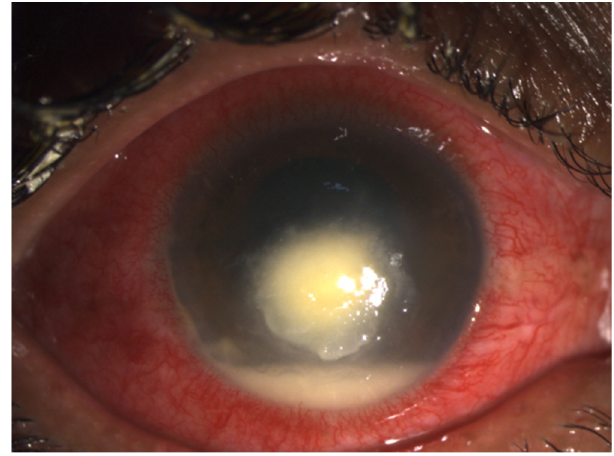
Figure 1. Clinical photograph of a 30 year old female patient with history of trauma to right eye showing central dry-looking corneal ulcer with feathery margins and hypopyon of 1.2 mm in size suggestive of fungal keratitis.